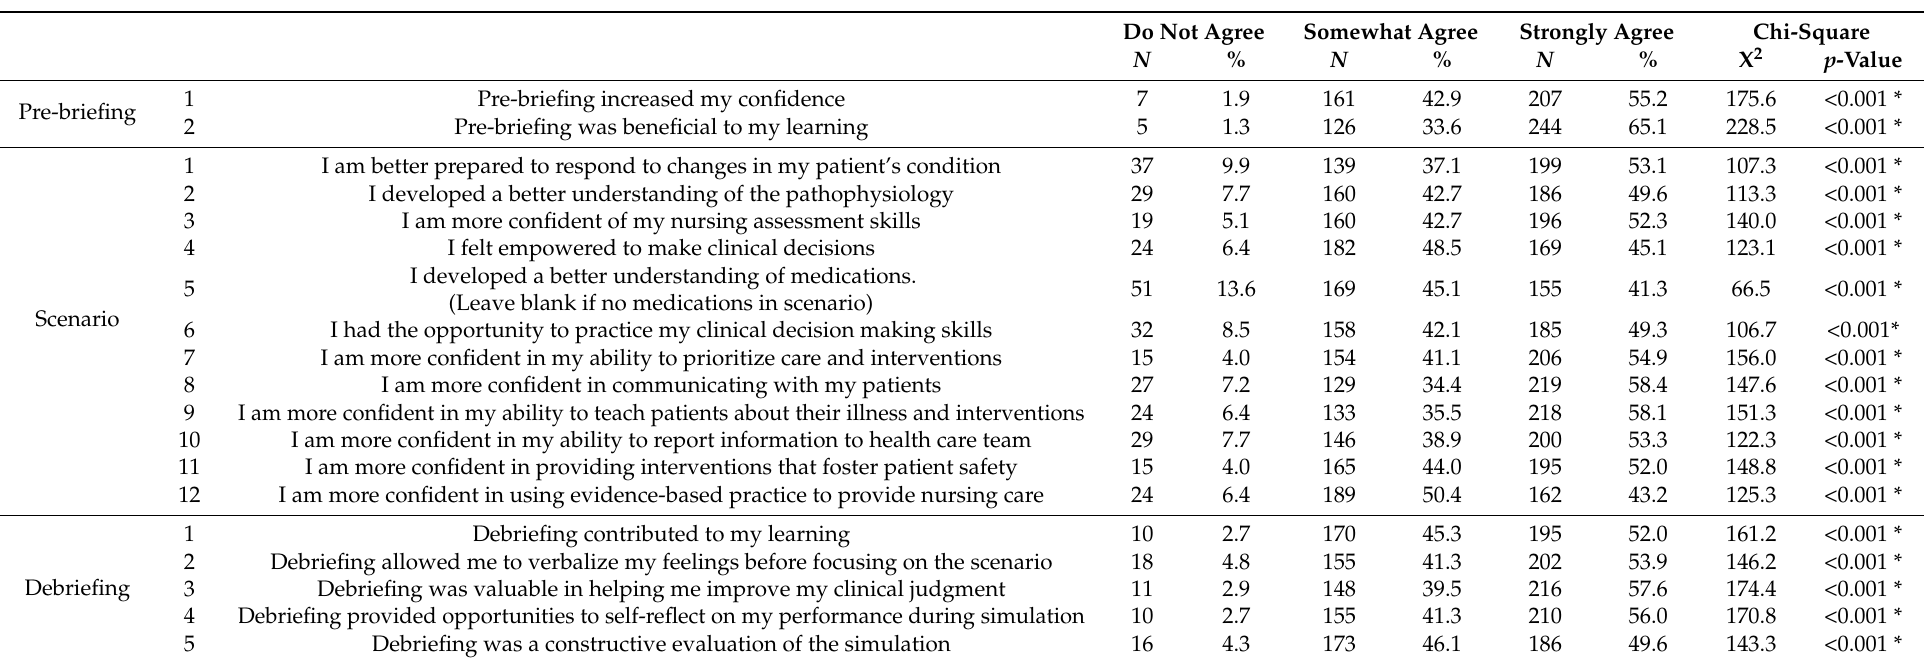
Table 2. The frequencies and percentages of agreement for the points of the domains ( n =